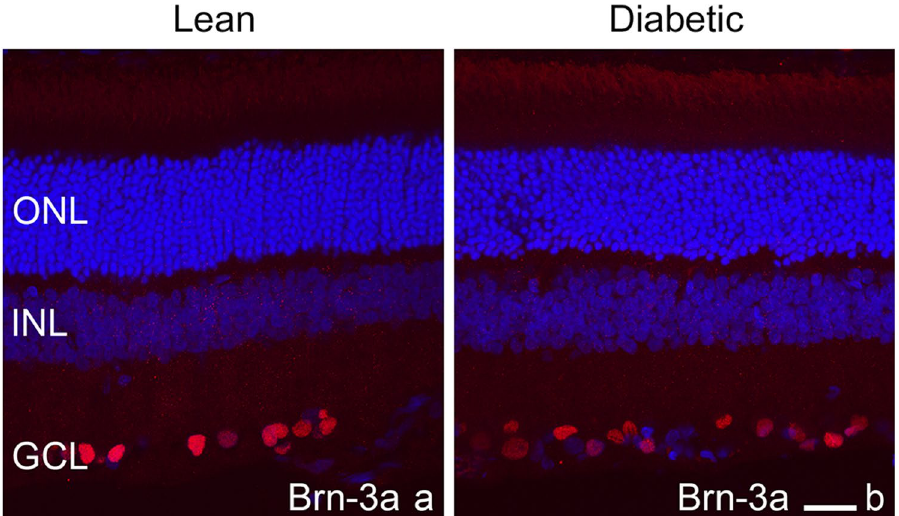
Figure 9. There was no major change in ganglion cell staining detected by Brn-3a antibody in control ( a ) and diabetic ( b ) specimens. DAPI is used as a nuclear staining. ONL: outer nuclear layer, INL: inner nuclear layer, GCL: ganglion cell layer. Bar : 20 μ